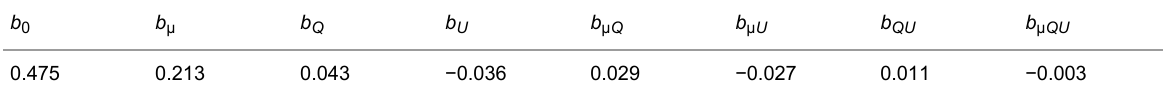
Table 9: The model coefficients determining the impact of solution dynamic viscosity (µ), solution flow rate ( Q ) and electrical voltage ( U ) on the aver- age beaded fiber diameter ( d ). b 0